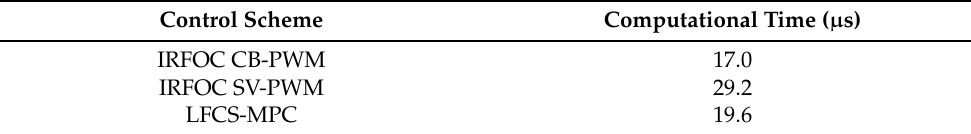
Table 5. Computational time of the considered regulation